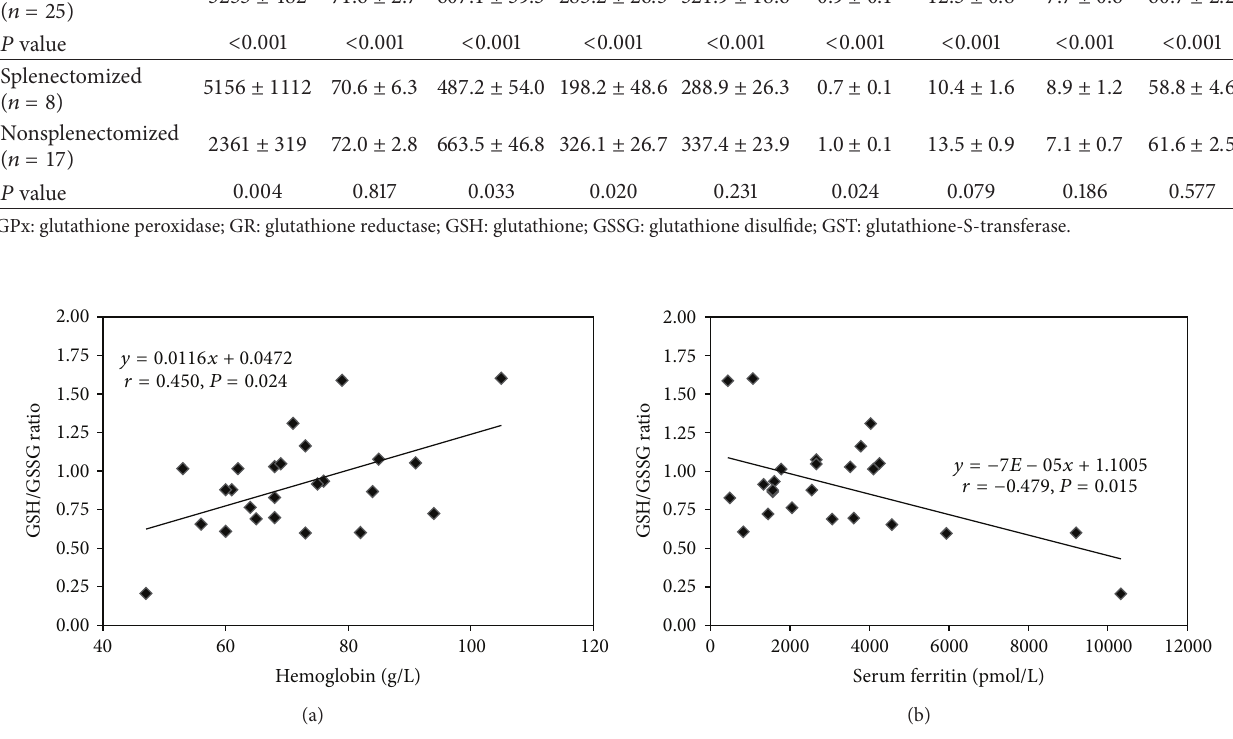
Figure 1: Linear regression analysis in 𝛽 -thalassemia/Hb E patients. (a) Correlation between hemoglobin level and GSH/GSSG ratio. (b) Correlation between serum ferritin level and GSH/GSSG